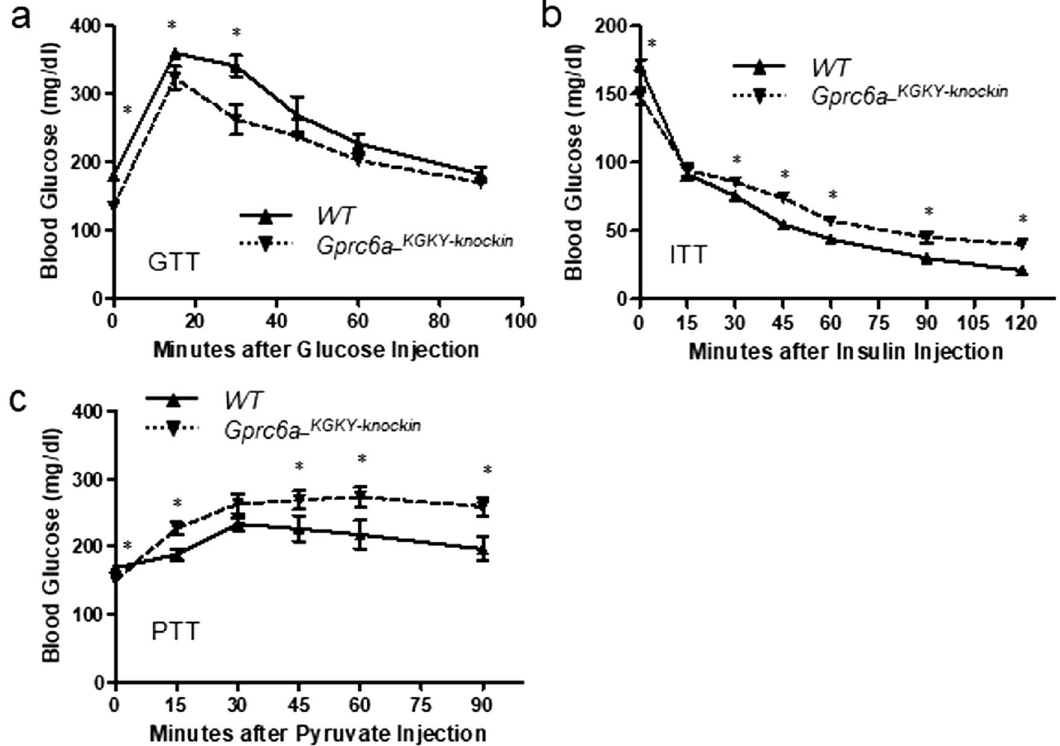
Figure 3. Tolerance tests in G prc6a- KGKY-knockin mice. Blood glucose (mg/ml) during GTT ( a ), ITT ( b ) and PTT ( c ) in 10-week-old wild type and Gprc6a- KGKY-knockin mice. Data represent the mean ± SEM from more than 5 male mice in each group. *Difference from wild type and Gprc6a- KGKY-knockin mice at P < 0.05, two-way ANOVA with Tukey’s multiple comparisons test.